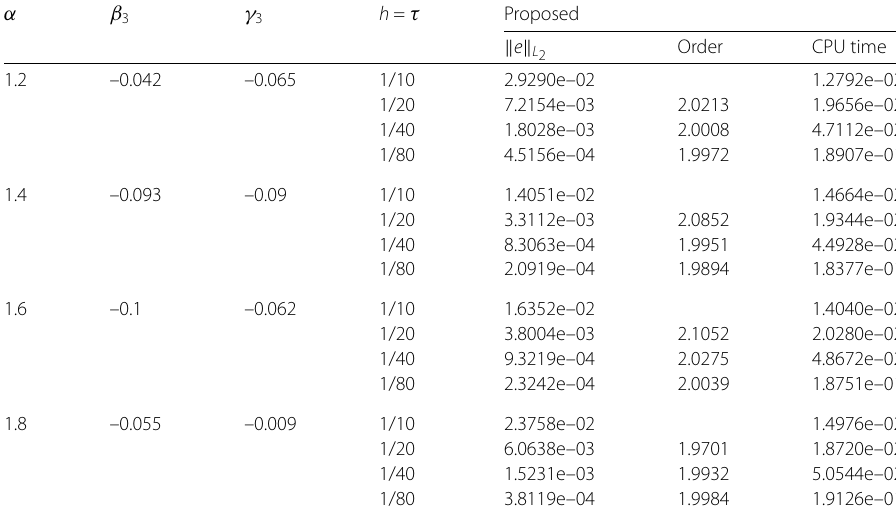
Table 9 Errors and corresponding observation orders at t = 1, λ = 2